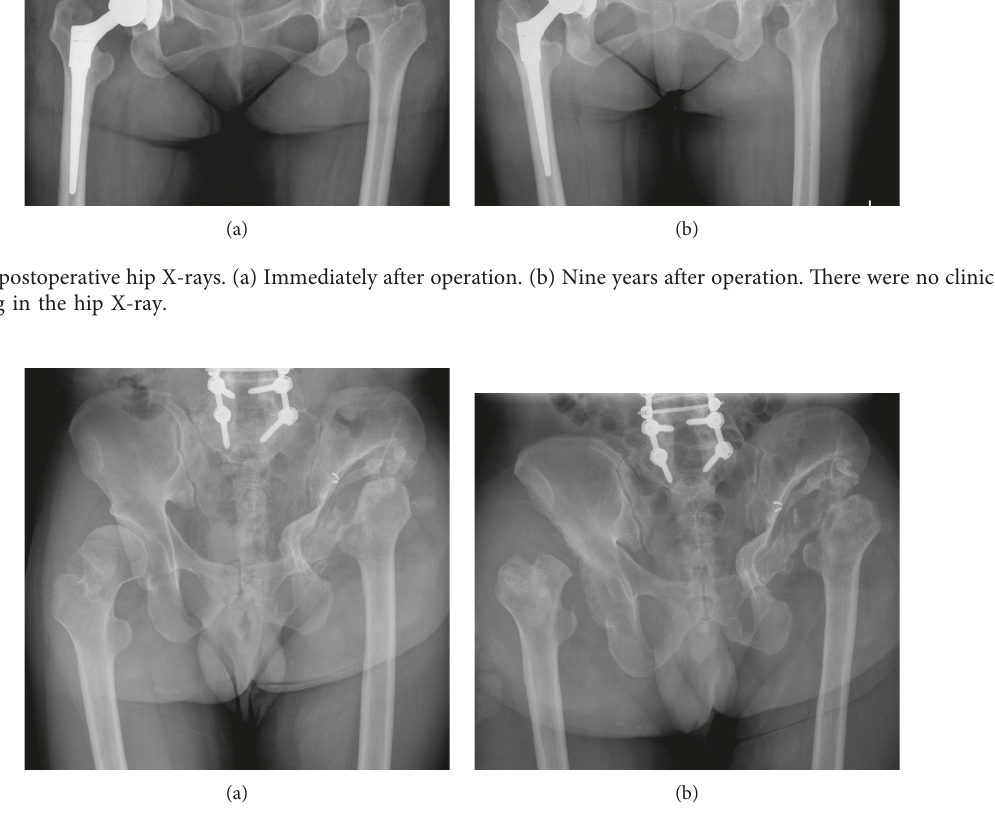
Figure 3: Case 2 preoperative hip X-rays. (a) Two months before admittance to our hospital. (b) Preoperative hip X-ray. A hip X-ray revealed the disappearance of right femoral head and destructive changes in the right